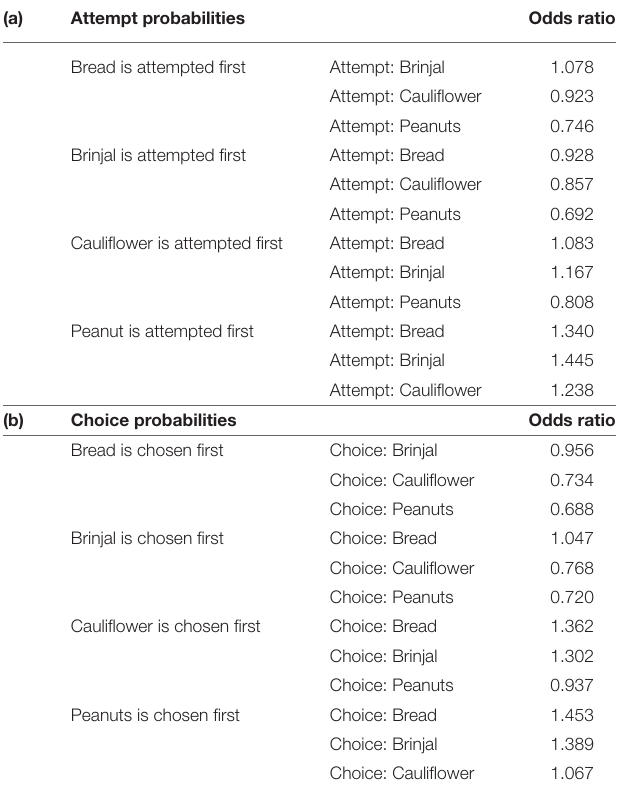
TABLE 2 | Table representing the odds ratio separately for (a) attempt, and (b) choice probabilities. (a) Attempt probabilities